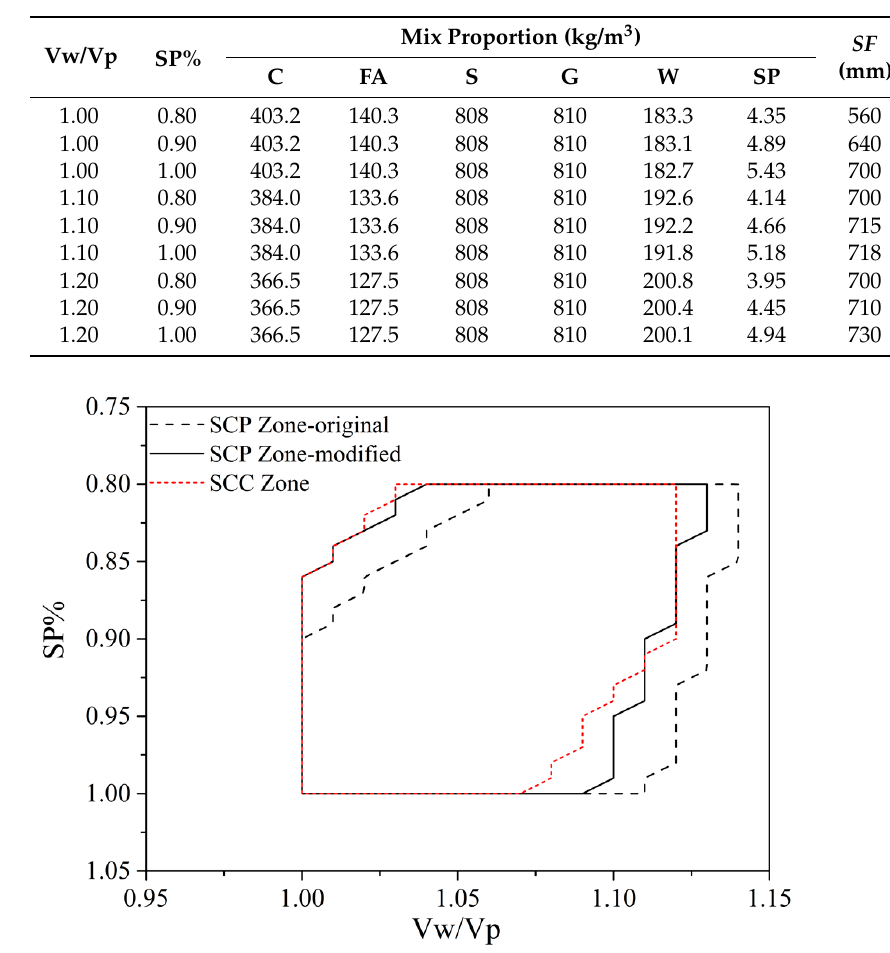
Figure 7. Self-compacting zones of series 3, cement substituted by 30% FA. As Figure 7 indicates, the original SCP zone is located to the right of the SCC zone, while the modified SCP zone is located between the original SCP zone and the SCC